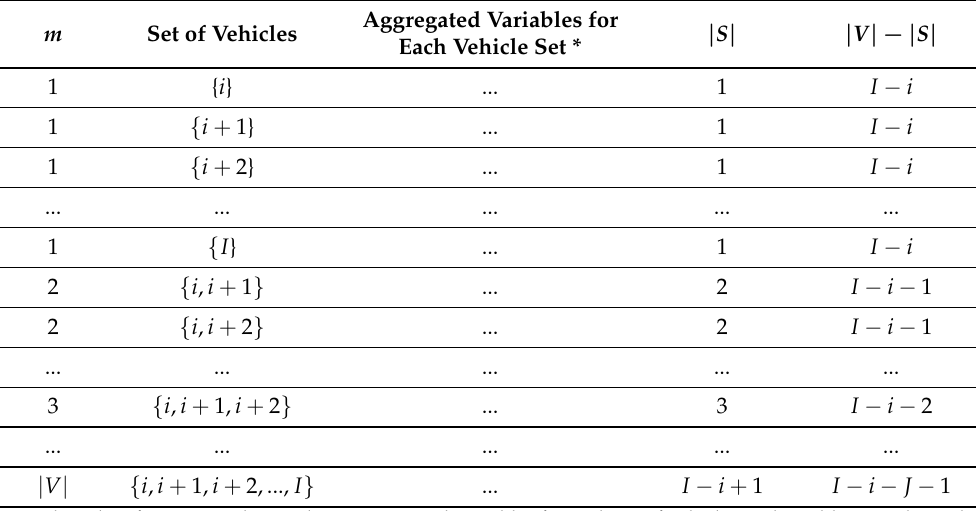
Table 4. Data structure defined for the aggregated